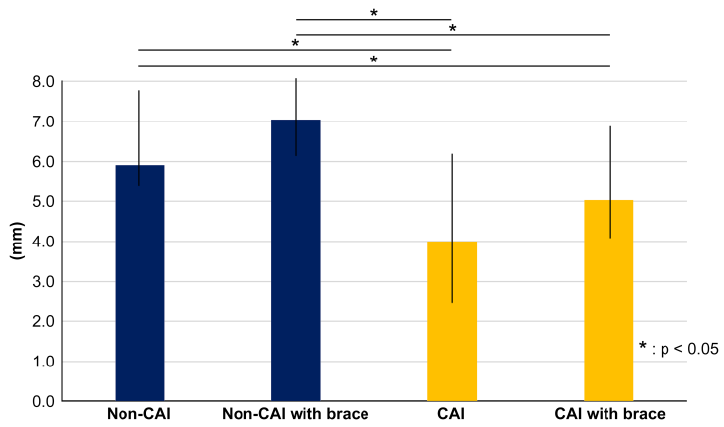
Figure 7. Graph showing the amount of change in anterior–posterior direction of the center of pressure. There was a significant difference between the CAI and non-CAI sides, but there was no significant difference between with or without the brace.